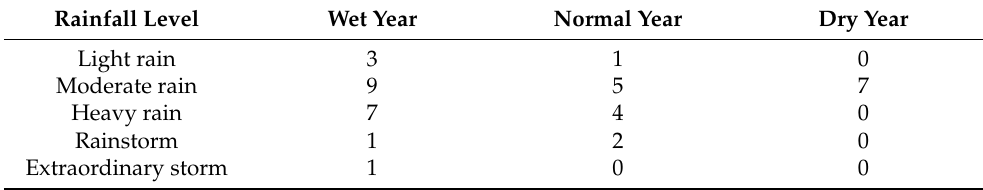
Table 5. The number of different rainfall levels in wet year, normal year and dry year.